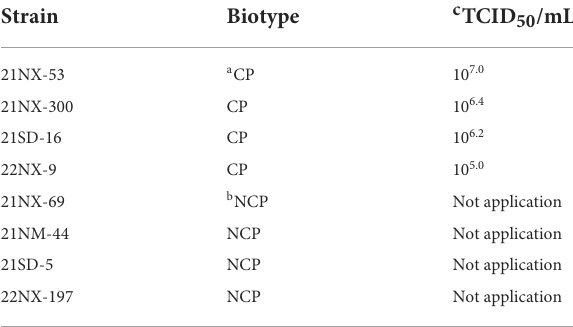
TABLE 2 The information about the eight filed BVDV isolates from sera samples. Strain